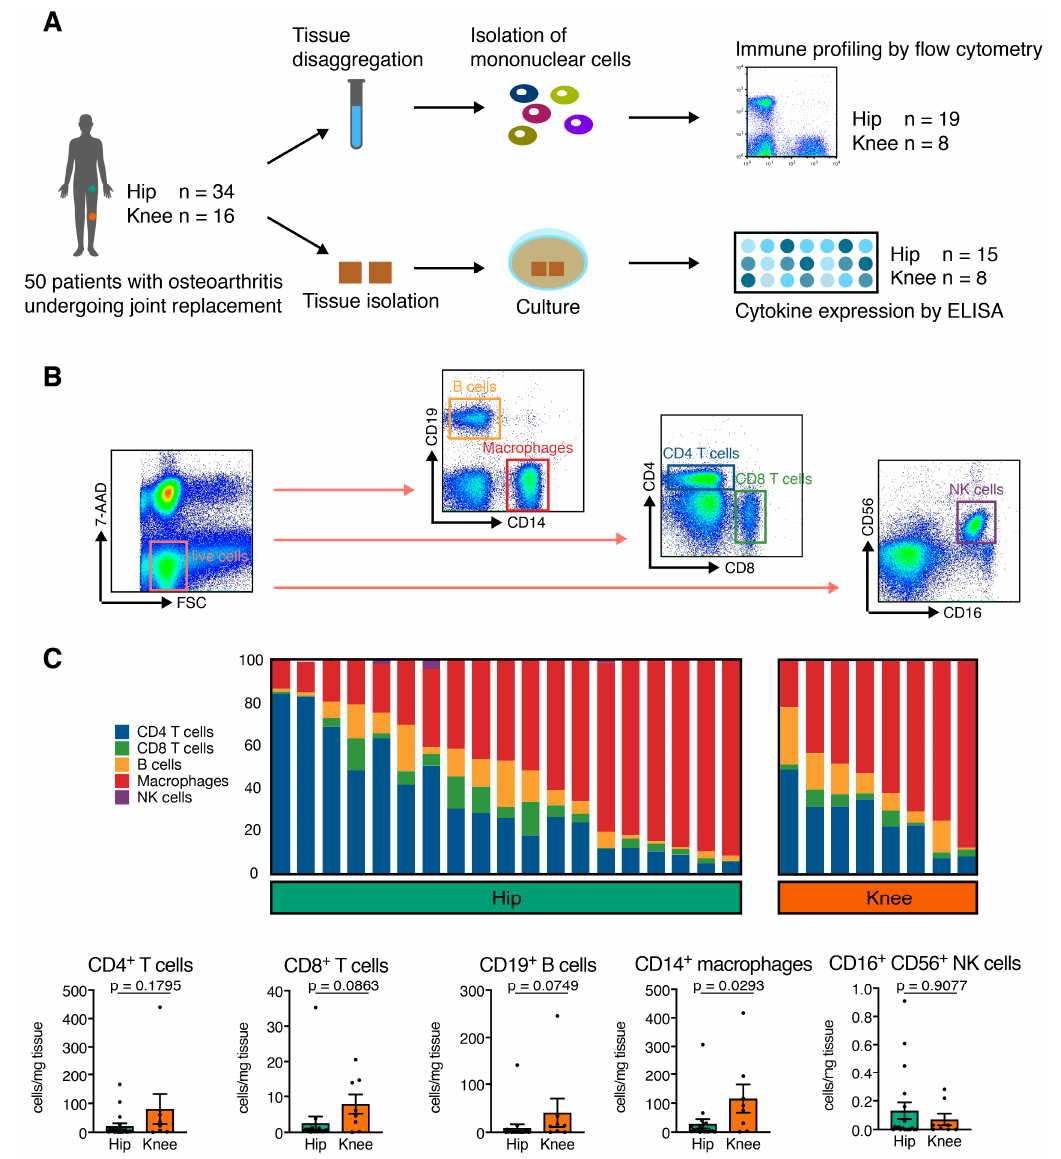
Figure 1. Harvesting of synovial membrane and flow cytometry and cytokine expression analysis of synovial membrane from patients with di ff erent types of osteoarthritis. ( A ) Synovial tissue was obtained from 50 patients with hip ( n = 34) and knee ( n = 16) osteoarthritis, disaggregated, and digested. Following fresh isolation of mononuclear cells, n = 19 hip and n = 8 knee samples were analyzed by flow cytometry to profile the contribution of di ff erent lineages. Cells from n = 15 hip and n = 8 knee OA samples were cultured for 24h, and quantitative release of 48 canonical cytokines was assessed using multiplex ELISA. ( B ) Schematic gating strategy to identify CD4 + T cells, CD8 + T cells, CD19 + B cells, CD14 + macrophages, and CD16 + CD56 + NK cells from disaggregated osteoarthritic synovial membrane. ( C ) Relative contribution of di ff erent mononuclear cell lineages to the synovial membrane infiltrate suggests a spectrum of mononuclear infiltration ranging between two poles, characterized by a predominantly CD4 T cell infiltrate and a predominantly macrophage infiltrate. ( D ) CD14 + macrophages and CD8 + T cells are expanded 3.8-fold in synovial membrane of knee OA compared to hip OA ( p = 0.0293 and p = 0.0863 by Mann–Whitney test).